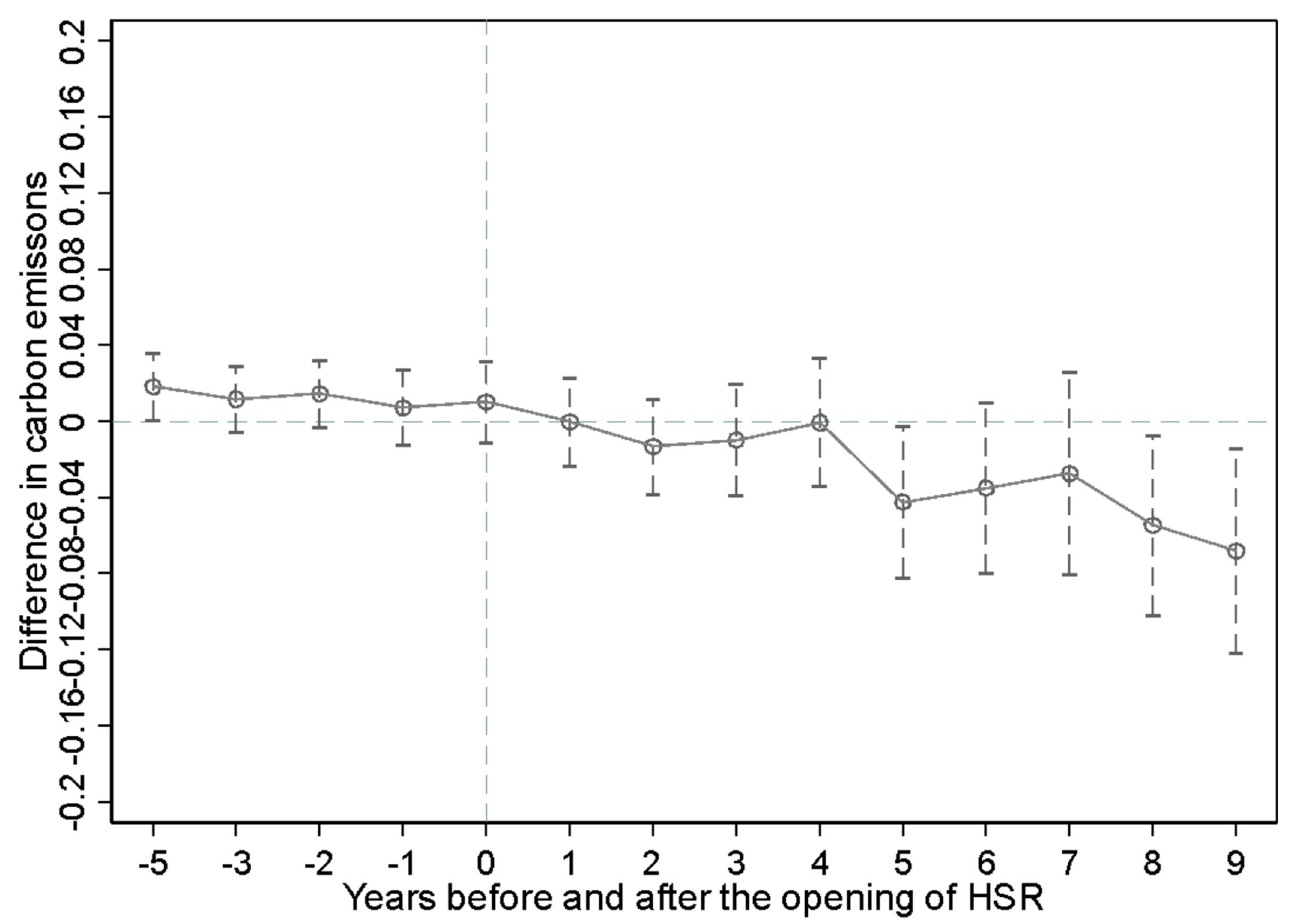
Fig 2. Parallel trend test and dynamic effect